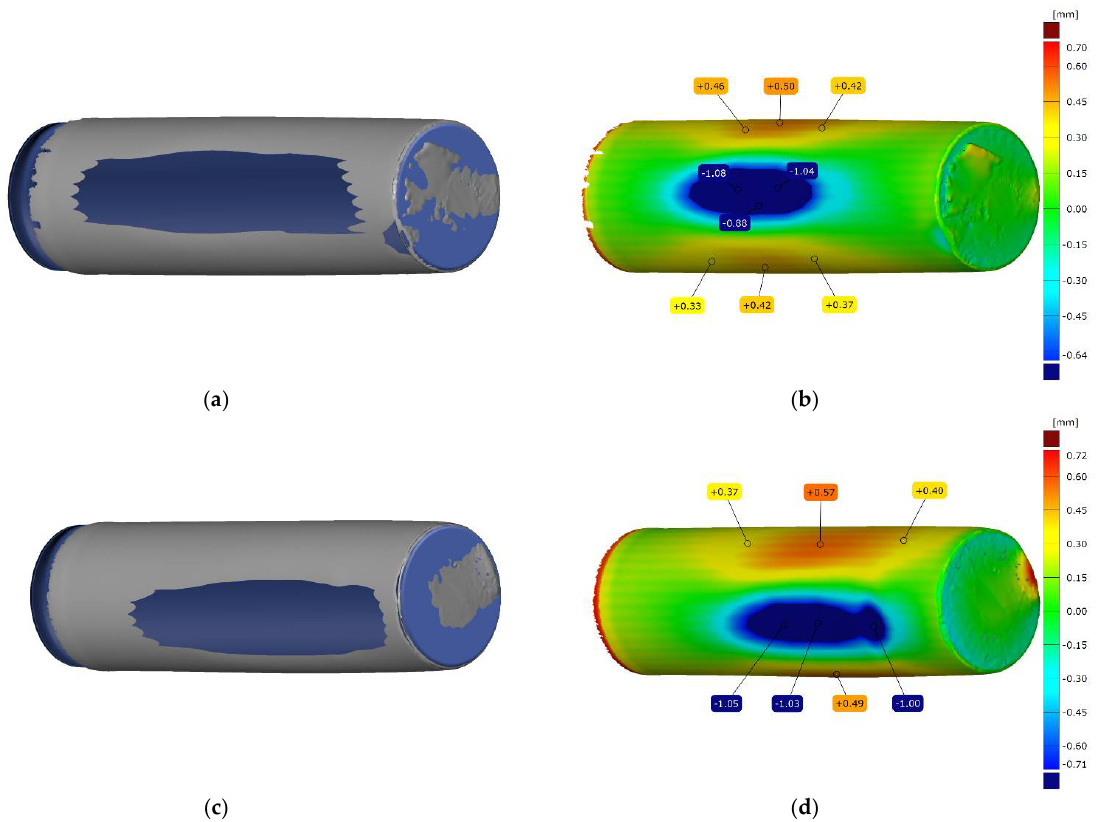
Figure 10. Surface comparison scanned deformed battery vs CAD data ( a ) first specimen alignment of the scanned mesh on the CAD; ( b ) first specimen deformation results; ( c ) second specimen alignment of the scanned mesh on the CAD; and ( d ) second specimen deformation